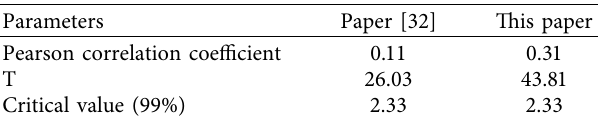
Table 11: Correlation analysis of sentence semantic complexity